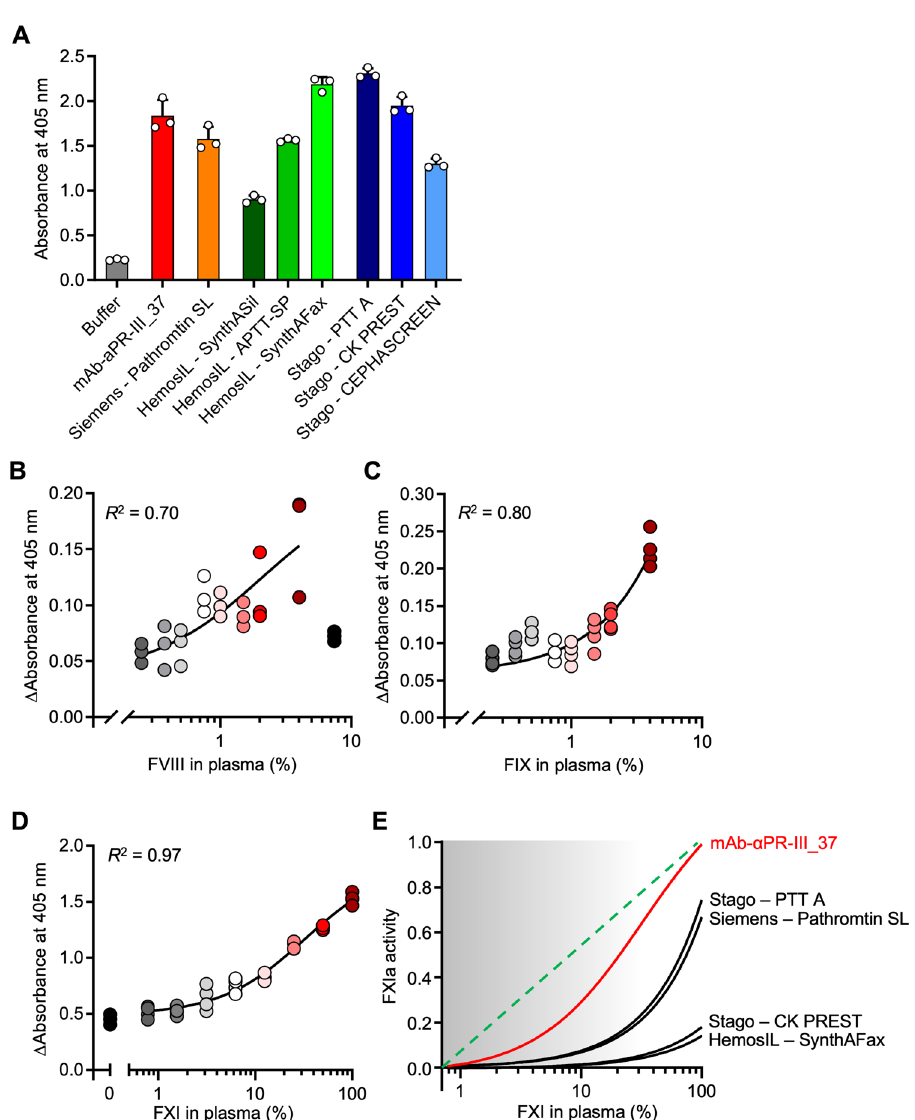
Fig. 8 mAb- α PR-III_37 as a tool for coagulation diagnostics. A Standardization of aPTT reagents: Normal PPP was incubated with buffer, mAb- α PR-III_37 (750 nM, molar ratio antibody:plasma FXII of 5:1) or commercially available aPTT reagents (diluted 1:200). FXIIa formation was measured by S2302 cleavage. n = 3 samples, experiments independently performed 8 times. Columns give means ± SD. B , C Analysis of FVIII and FIX de fi ciency: Normal PPP was mixed with FVIII-de fi cient ( B ) or FIX-de fi cient ( C ) plasma to establish the precise FVIII and FIX levels in each reaction. Samples were incubated with mAb- α PR-III_37 (37.5 nM, molar ratio of 1:1 with plasma FXII) or buffer in the presence of CaCl 2 , phospholipids and H-Gly-Pro-Arg-Pro-OH acetate salt for 30 min. FXa formation in mAb- α PR-III_37-treated samples was measured photometrically using S2222 conversion for 180 min and corrected for the absorbance of buffer-stimulated samples. B , C shows n = 3 samples, experiments independently performed 5 times. D FXI analysis: Normal PPP and FXI- de fi cient plasma were mixed to obtain de fi ned FXI plasma concentrations. Samples were incubated with mAb- α PR-III_37 (750 nM, molar ratio antibody:plasma FXII of 5:1) or buffer for 180 min. FXIa formation in antibody stimulated samples was measured using the S2366 substrate and was blotted following correction for buffer, background levels. E mAb- α PR-III_37 but not particulate aPTT agents accurately measures FXI plasma levels: Normal PPP and FXI-de fi cient plasma were mixed to obtain de fi ned FXI plasma concentrations. Plasmas were incubated with mAb- α PR-III_37 (5:1 molar ratio) or various aPTT reagents. FXIa formation was measured using the S2366 substrate and were blotted following correction for FXI-de fi cient plasma background levels. R 2 -values were calculated by a non-linear regression curve (agonist vs . response, 3 parameters). D , E shows n = 4, experiments independently performed 5 procoagulant activity of contact activation-de fi cient FXII mutants (Fig. 2A).